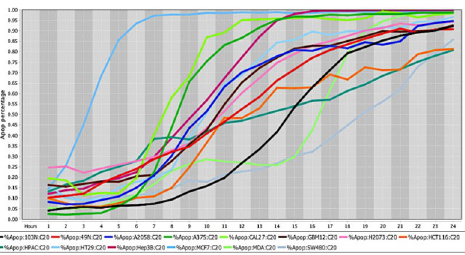
Fig 1. Cell death response curve for a variety of human cancers. Cell death response expressed in percentage of apoptosis in fourteen human cancer cell lines exposed to CT at 20 μ M concentration. Cancer cell lines are represented by colored lines: colorectal cancer (103N- black, 49N- red, HCT116-orange, HT29- light blue, SW480- gray), melanoma (A2058- royal blue, A375- green), squamous cell carcinoma (CAL27- neon green), glioblastoma (GBM12- brown), lung adenocarcinoma (H2073- pink), pancreatic adenocarcinoma (HPAC- dark green), hepatocellular carcinoma (Hep3B- maroon), breast adenocarcinoma (MCF7- sky blue), breast carcinoma (MDA-MB-453- light green).